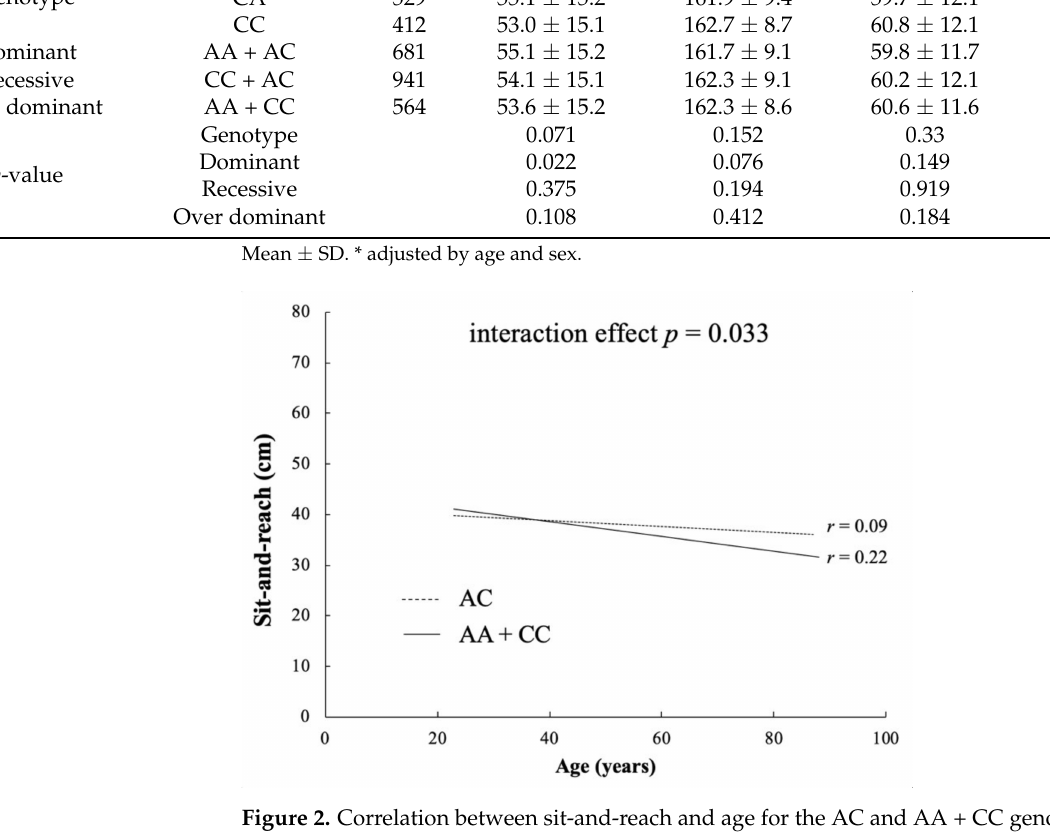
Figure 2. Correlation between sit-and-reach and age for the AC and AA + CC genotypes in COL1A1 rs1107946